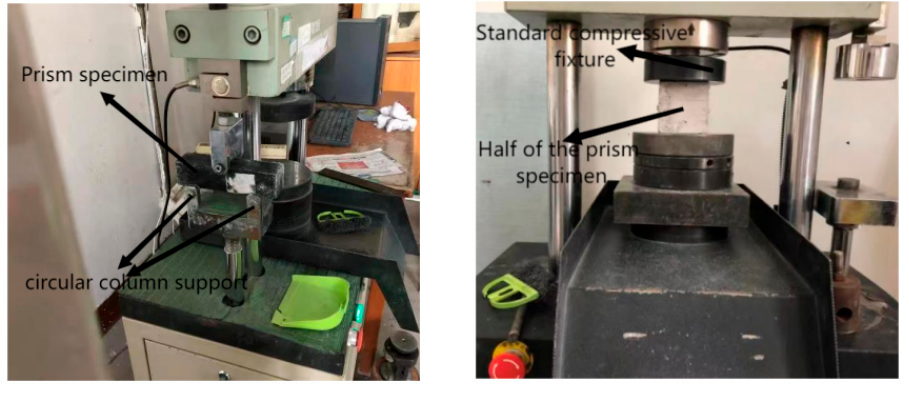
Figure 2. Measurement of mechanical strengths.